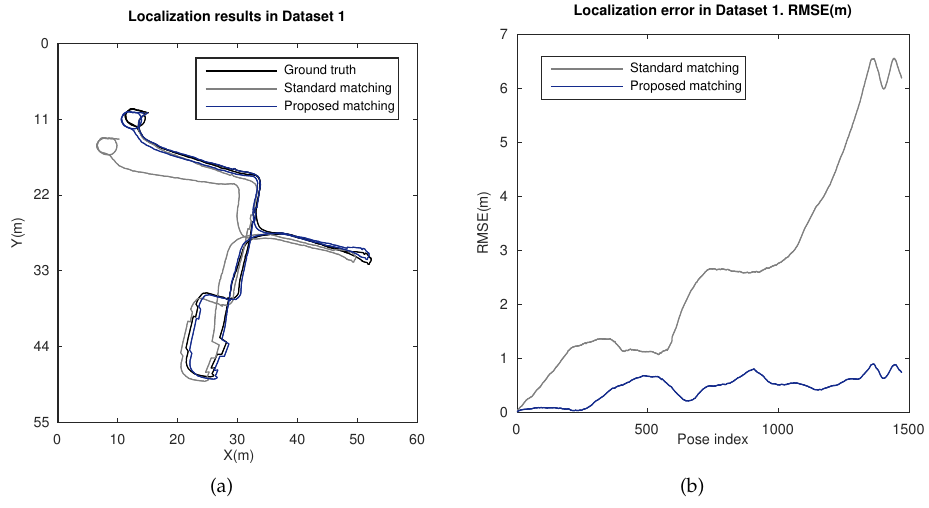
Figure 14. Localization results in Dataset 1, Innova trajectory . ( a ) Localization estimation obtained with ground truth (black), standard matching (grey), and the proposed matching (blue); ( b ) RMSE (m) for the localization estimation with standard matching (grey) and the proposed matching